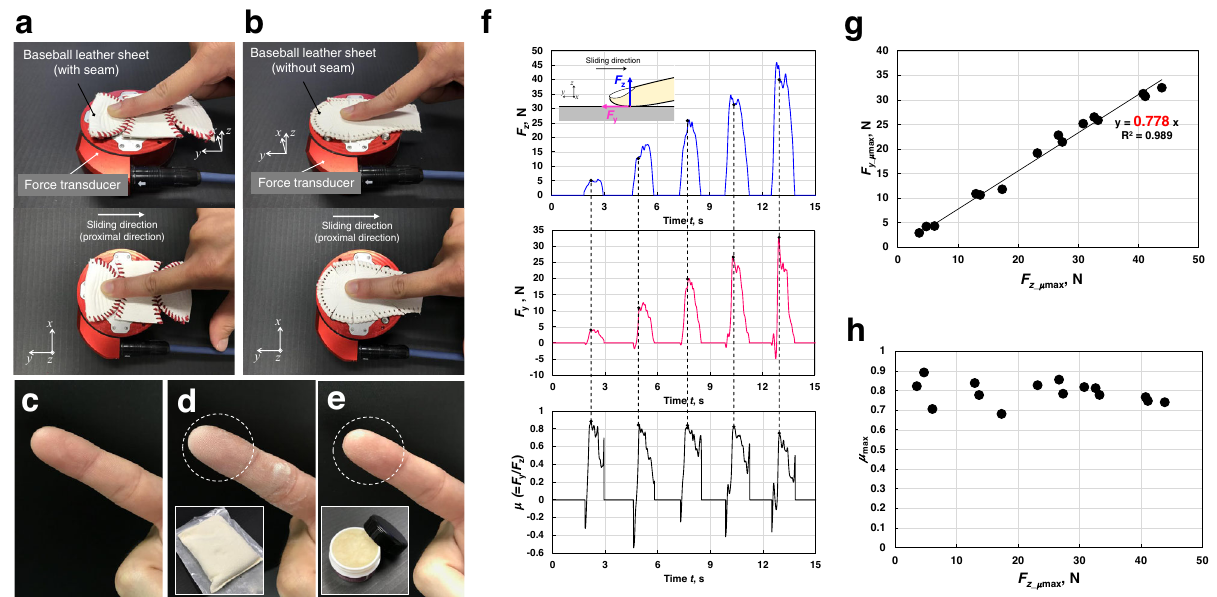
Fig. 1 Measurement of friction between fi ngertip and baseball leather sheet. a , b Experimental setup for MLB ball leather sheet with seam ( a ) and that for MLB ball without seam ( b ). c – e Finger conditions; no application ( c ), rosin application ( d ), and sticky substance application ( e ). f An example of time series of the normal force ( F z ), the horizontal force ( F y ), and the friction coef fi cient µ ( F y / F z ) during a single trial in which an index fi ngertip is slid with fi ve different levels of the normal force. g The relation between horizontal ( F y_ μ max ) and normal forces ( F z_ μ max ) at the maximum friction coef fi cient µ max . Using this plot, we calculated the mean µ max as the slope of the least square regression square line (e.g., 0.778 in g ). h The relation between the µ max and F z_ μ max . Using this plot, we evaluated the dynamic change of friction across the applied normal force. The data in g and h were collected from three trials at fi ve force levels (15 slides) under no application conditions for MLB ball without participant CV of µ max was not affected by ball type condition ( r = 0.827 for MLB ball with seam, p < 0.01; r = 0.685 for MLB ball without seam, p < 0.05) (Fig. 4a, d); however, the ball type-seam interaction correlation coef fi cient was smaller in rosin (Fig. 4b, e) and sticky ( F [1,8] = 1.726, p > 0.05, η p 2 = 0.177) (Fig. 6b). As shown in substance application conditions (Fig. 4c, f). Fig. 6c, the between-participant CV for MLB ball (0.235 with seam and 0.220 without seam) was not signi fi cantly different from that for NPB ball (0.179 with seam and 0.255 without seam). The effect of rubbing with mud/sand on the friction coef fi - cients of MLB and NPB balls . Figure 7 shows the group mean µ max of MLB and NPB balls rubbed with and without mud and sand, respectively. Two-way repeated measures ANOVA revealed that the mean µ max of balls with seam (Fig. 7a) tended to be affected by the type of ball ( F [1,4] = 6.588, p = 0.062, η p 2 = 0.622) but was unaffected by rubbing with mud/sand ( F [1,4] = 0.333, p = 0.595, η p 2 = 0.077) and ball-rubbing inter- actions ( F [1,4] = 0.706, p = 0.448, η p 2 = 0.150). A post hoc t -test with Bonferroni correction revealed that the mean µ max of MLB balls with seam (95% CI: 0.672 – 1.081 without rubbing; 95% CI: 0.675 – 1.074 with rubbing with mud) was smaller than that of NPB balls both with (95% CI: 0.770 – 1.267, p = 0.115, Cohen ’ s d = 0.793) and without (95% CI: 0.753 – 1.182, p = 0.047, Cohen ’ s d = 0.573) rubbing with sand. For balls without seam (Fig. 7b), two-way repeated measures ANOVA revealed that the mean µ max was signi fi cantly affected by the type of ball ( F [1,4] = 10.043, p = 0.016, η p 2 = 0.715) but was unaffected by rubbing with mud/ sand ( F [1,4] = 1.853, p = 0.245, η p 2 = 0.317) and ball-rubbing